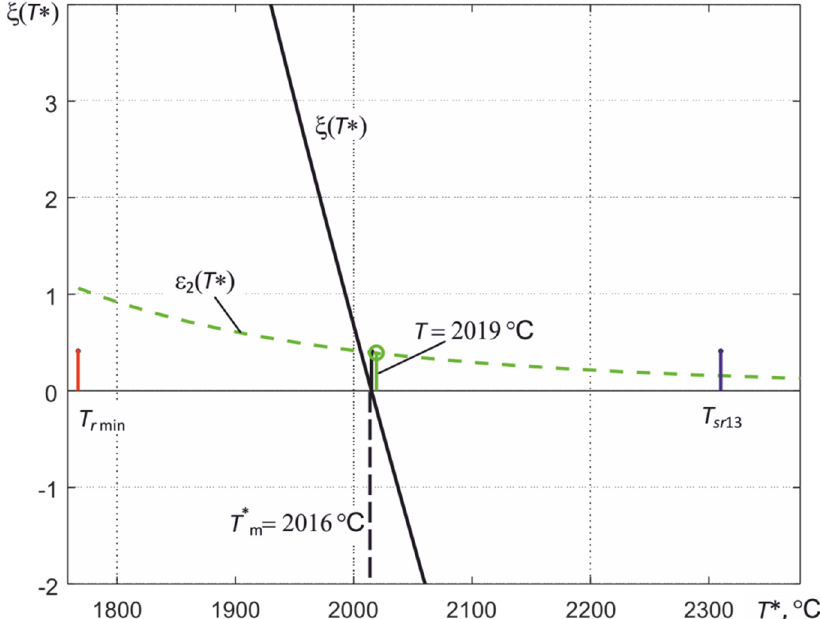
Figure 11. Illustration of the process of finding a solution to Equation (22) when determining the temperature of the region of maximum heating of the tungsten tape of the standard incandescent lamp SI10-300.